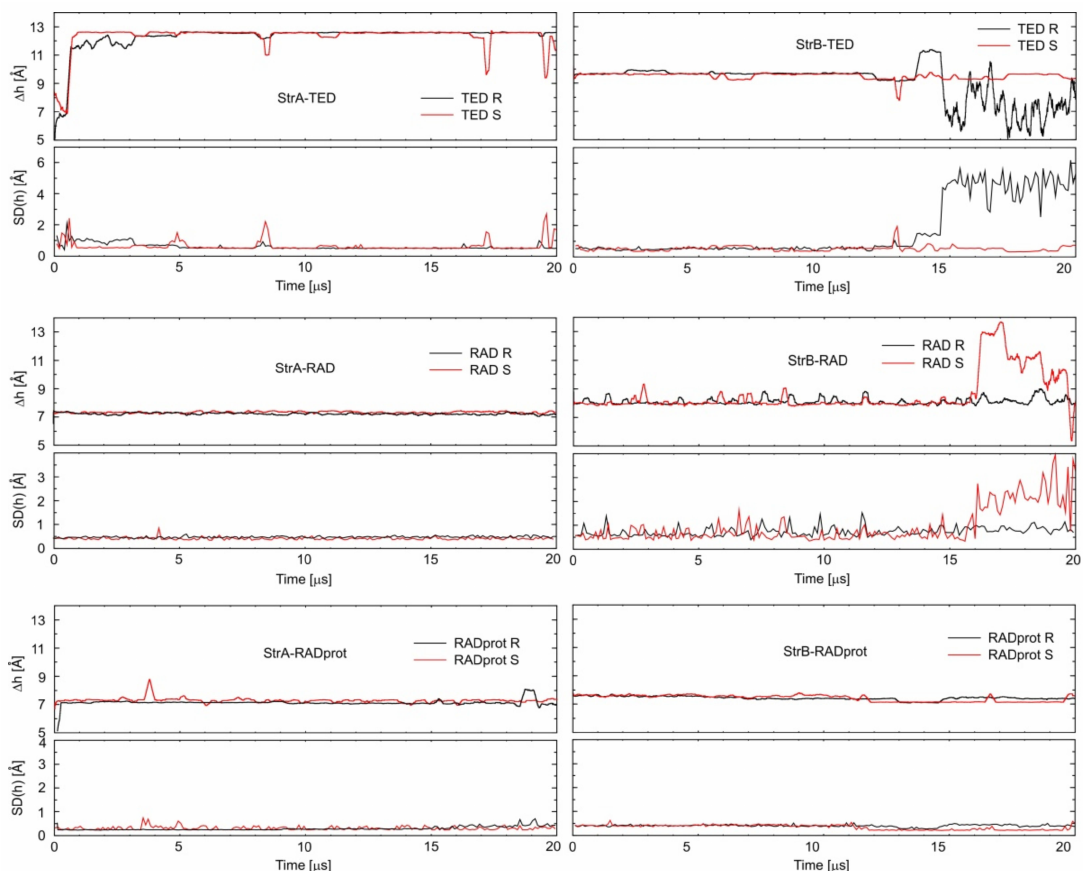
Figure 5. Changes in the distances ∆ h (and its standard deviations SD(h)) between the asymmetric carbon atom of oxazolidinone and the plane intersecting the centers of the cyclodextrin sugar rings during MD